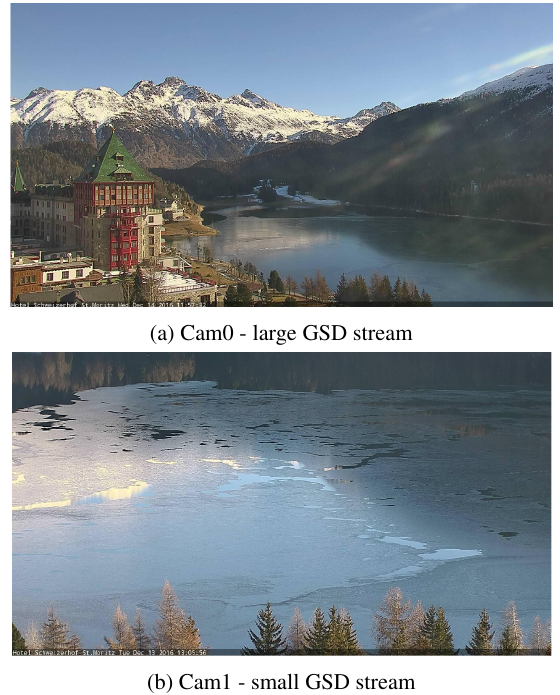
Figure 2. Example images of the two webcam